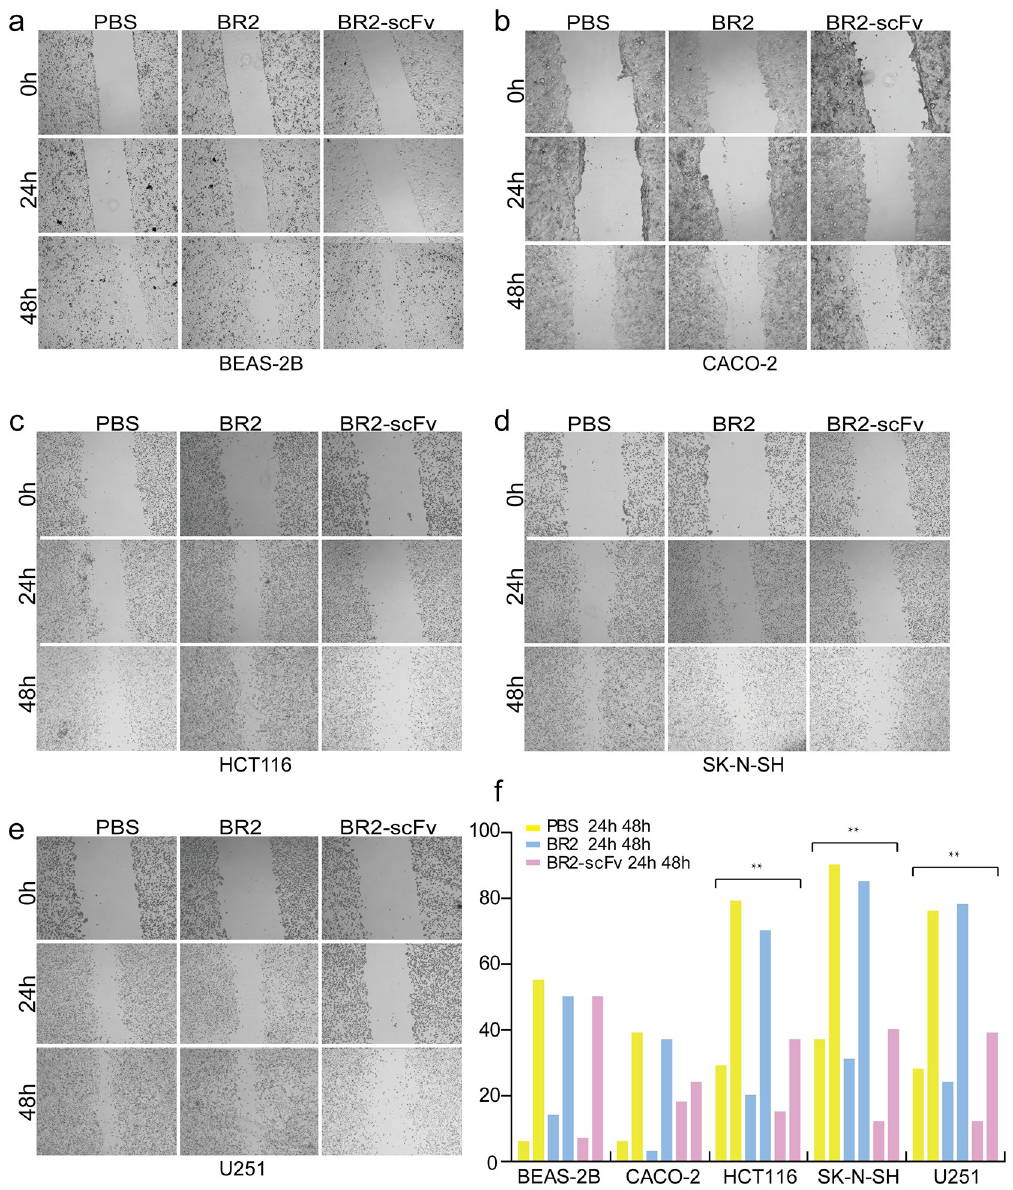
Fig 4. The antitumor efficacy of BR2-p21Ras scFv(BR2- scFv) in vitro. ( a ) The normal cell BEAS-2B without GS was no significant difference of wound healing ability among PBS, BR2 and BR2- scFv treatment group. ( b ) Human colonadenocarcinoma celll line CACO-2, which expressed GS but did not have ras mutation, was no obvious distinctions of wound healing ability in BR2- scFv group compared with the control group PBS and BR2 ( c-e ). The wound healing ability of the BR2- scFv group was slower than the BR2 and PBS groups at 24 and 48 h in HCT116(c), SK-N-SH(d), and U251 cells(e). ( f) Calculating the percentage of migrating cells, the BR2-scFv group was lower than the BR2 and PBS groups in HCT116, SK-N-SH, and U251 cells at 24 and 48